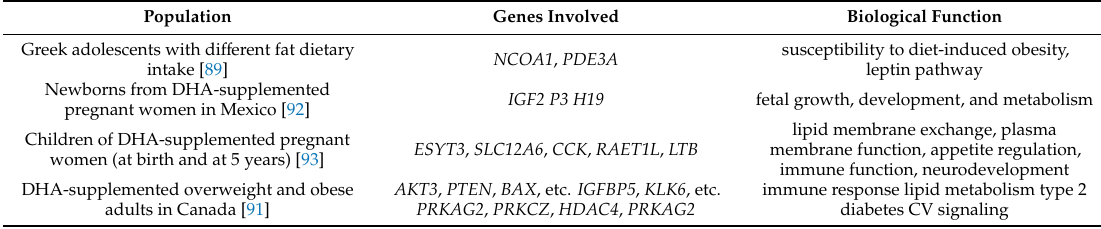
Table 4. LCPUFAs’ impact on DMR regions in human controlled